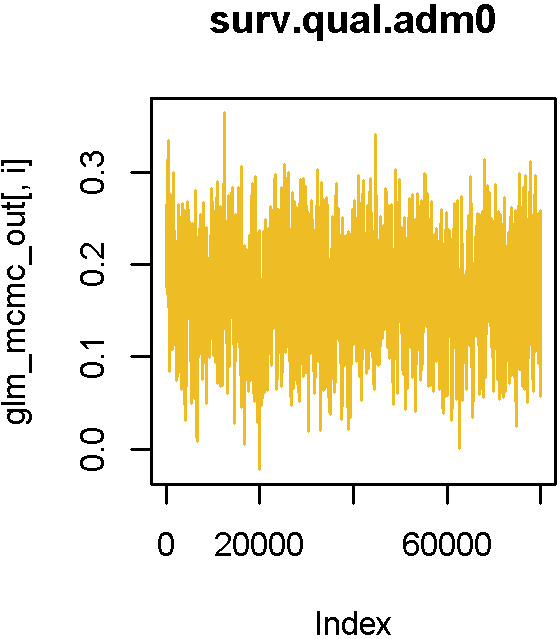
Trace plots from estimation of model variant 17 as an example of convergence.